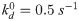
Mean quantities in the regime of non-progressive gel front.(a) Status of actin filaments during the whole simulation time. For this system the attachment rate is constant, ka = 1 s−1, and the force-free detachment rate is kd0=0.5s-1. We have 25 filaments in the system which are shown in the horizontal axis. The blue and the black color represent the detached and attached status of the filaments, respectively. (b) The mean number of attached and detached filaments versus time. (c) The average force that attachment and detachment filaments apply on the membrane as a function of time. (d) The mean attachment and detachment time of the filaments versus time.